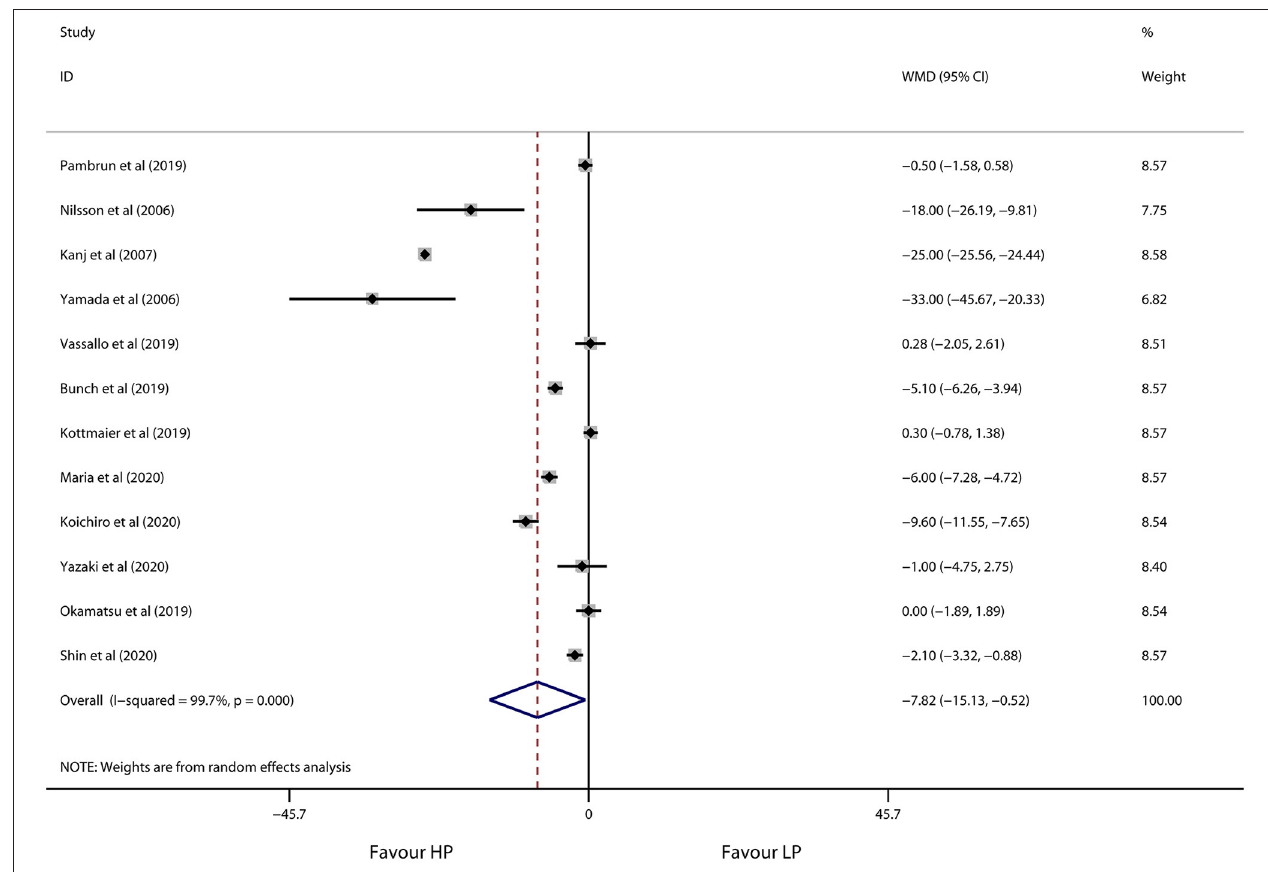
FIGURE 5 | Forest plot of fluoroscopy time for high-power ablation vs. conventional-power ablation.